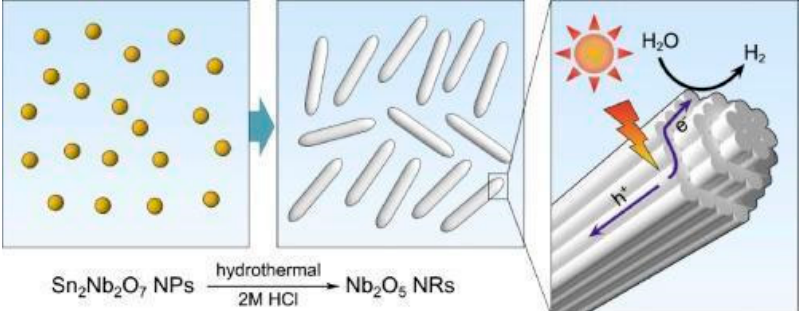
Figure 2. Scheme of Nb 2 O 5 nanorod superstructures synthesis and the improved photogenerated charge carries separation. Reproduced with permission from the authors of [24]. Copyright (2019), Elsevier, Amsterdam, Netherlands.